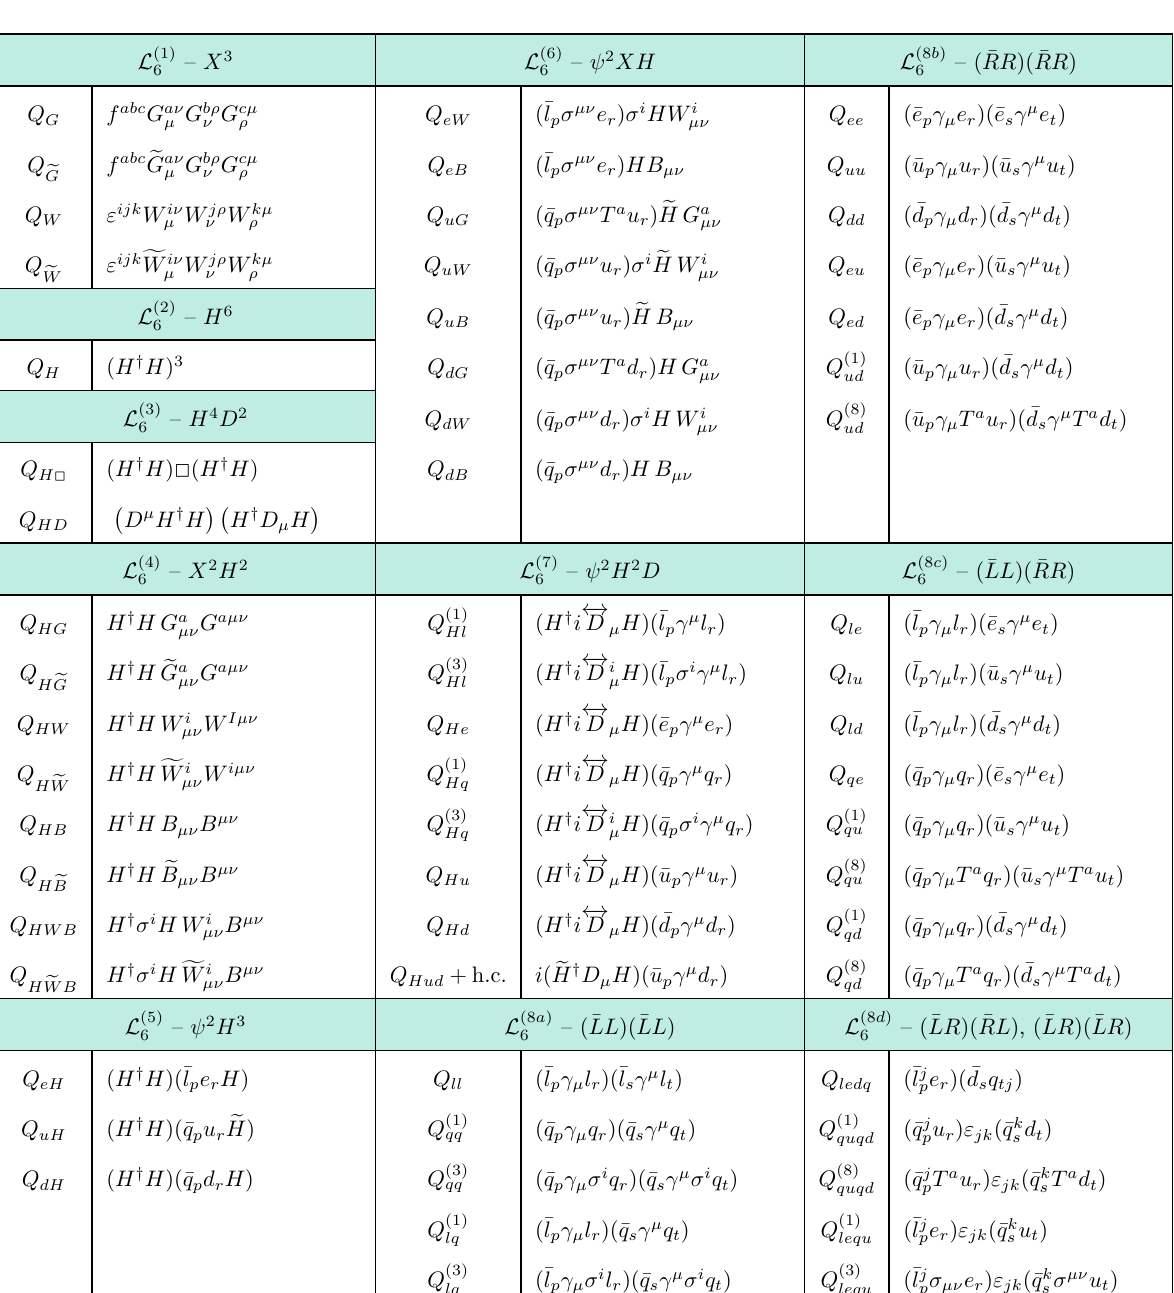
as in [48]. Only 6